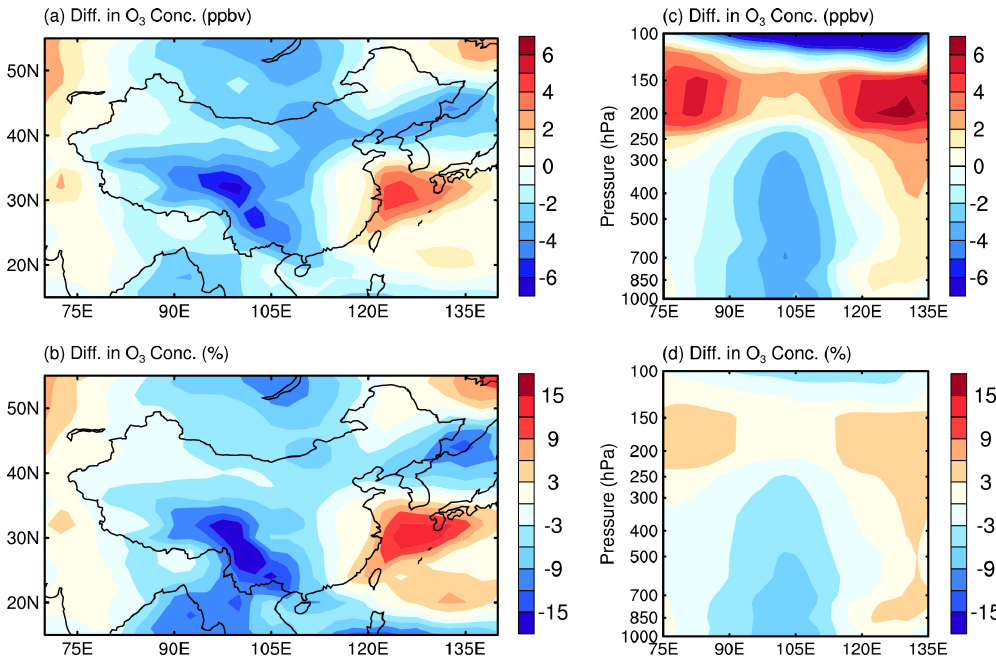
Figure 4. Horizontal distributions of (a) absolute and (b) percentage differences in JJA surface-layer O 3 concentrations between the five weakest and strongest EASM years (weakest–strongest). Pressure–longitude cross sections averaged over 20–46 ◦ N for (c) absolute and (d) percentage differences in JJA O 3 concentrations between the five weakest and strongest EASM years (weakest–strongest). Results are from simulation O 3 _TOT and the unit is shown on top of each panel.